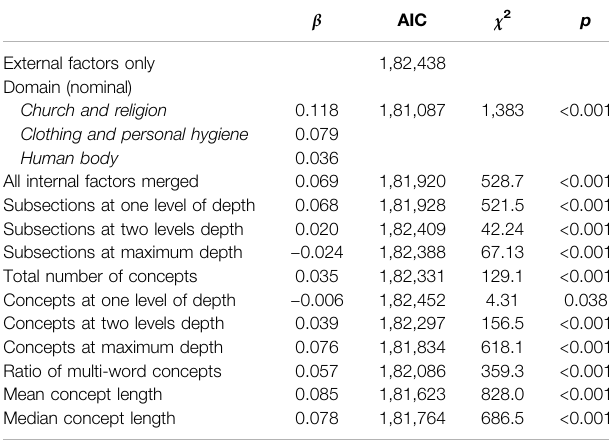
TABLE16| Overviewofmodelsincludinglanguage-internalfactors,showingbeta coef fi cients, Akaike information criterion values compared to the baseline model with external factors only, χ 2 -values, and signi fi cance